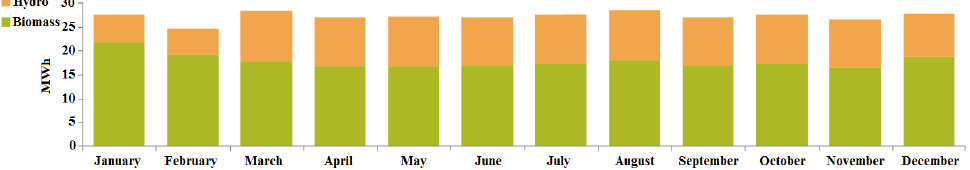
Figure 12. Electrical energy generation on a monthly basis for case I (Ba/Bi/H).